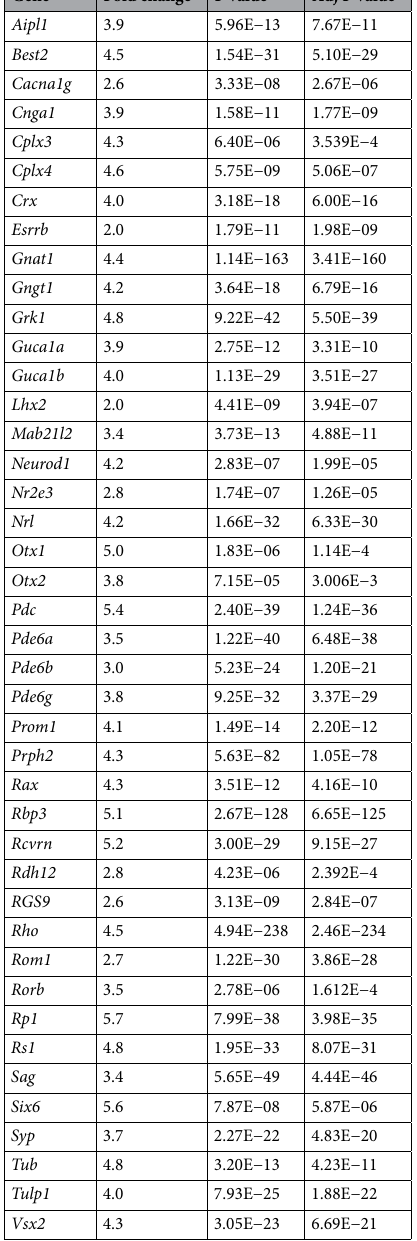
Table 1. Upregulated expression of retinal genes in the S100A4 −/− mouse